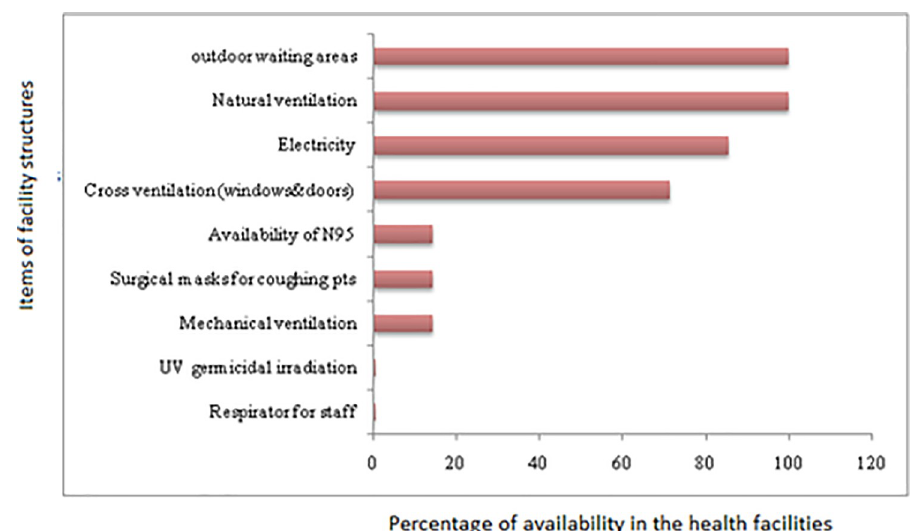
Fig 4. Availability of facility structures for appropriate TBICP measures in Dale district, Sidama Zone, Southern Ethiopia.